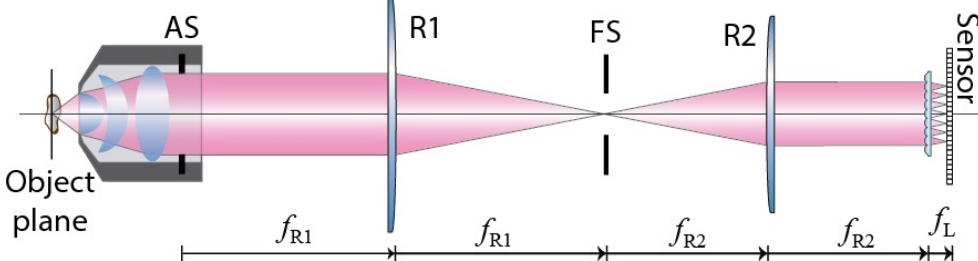
Figure 2. Fourier lightfield microscope optical scheme. The afocal relay R1–R2 projects an image of the aperture stop (AS) onto the lens array. Between them, a field stop (FS) is placed at the plane of the intermediate image, to avoid overlapping between the EIs formed by the lens array. The sensor is placed at the back focal plane of the lens array, so that it conjugated to the object